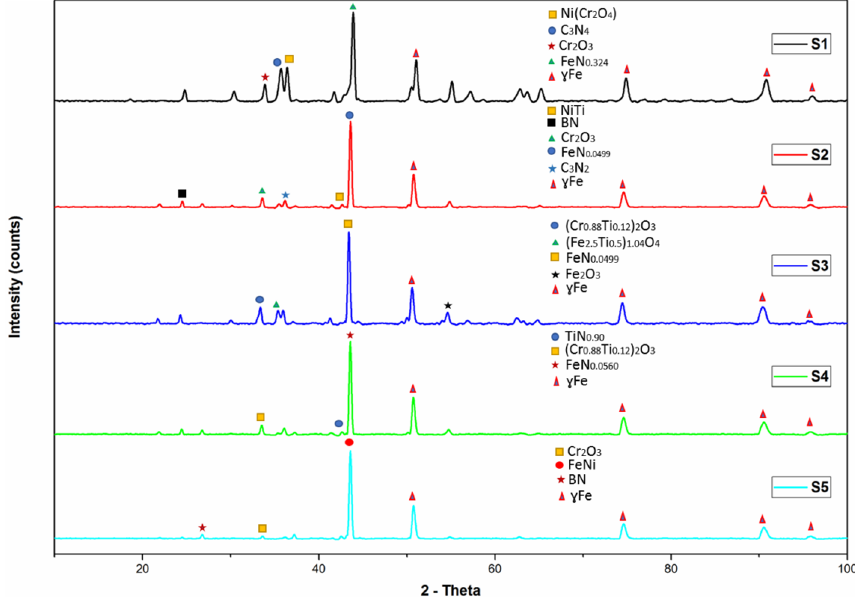
Figure 7. XRD spectra for all specimens.